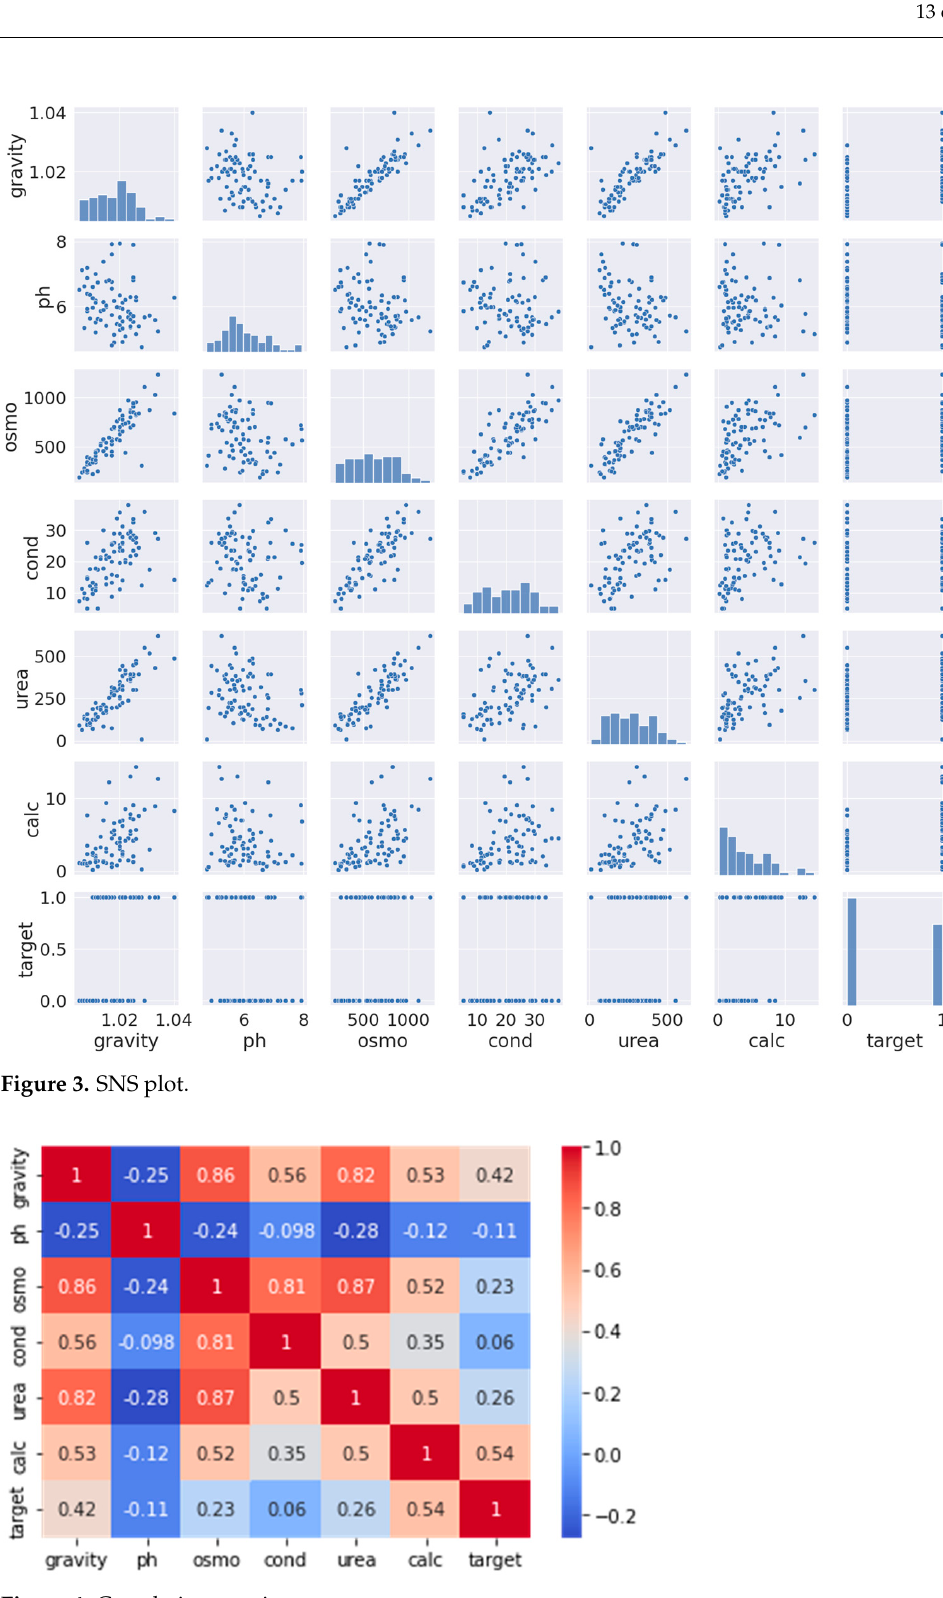
Figure 4. Correlation matrix.